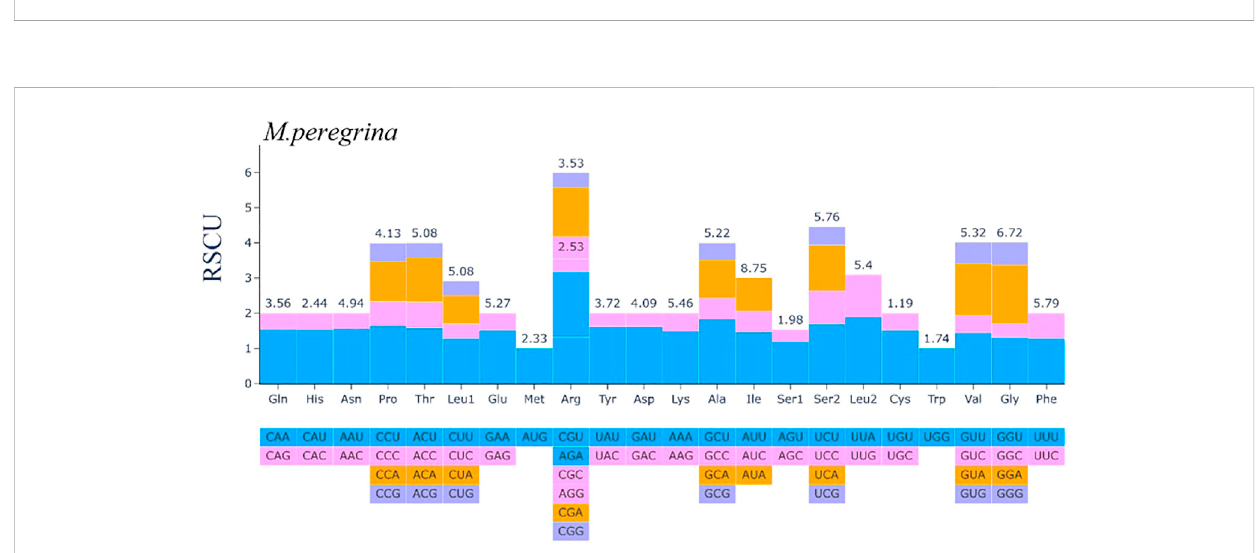
FIGURE 4 The codon Usage Bias of the plastomes structure of M. peregrina in all protein-coding genes.